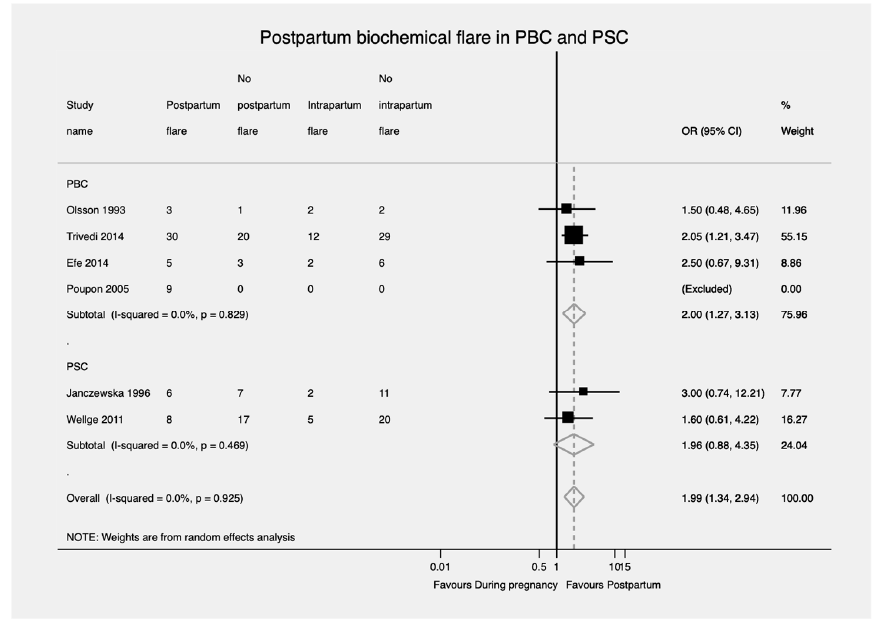
Figure 6. Biochemical flare during postpartum in PBC and PSC. PBC—Primary biliary cholangitis. PSC—Primary sclerosing cholangitis; OR—Odds ratio; CI—Confidence interval.